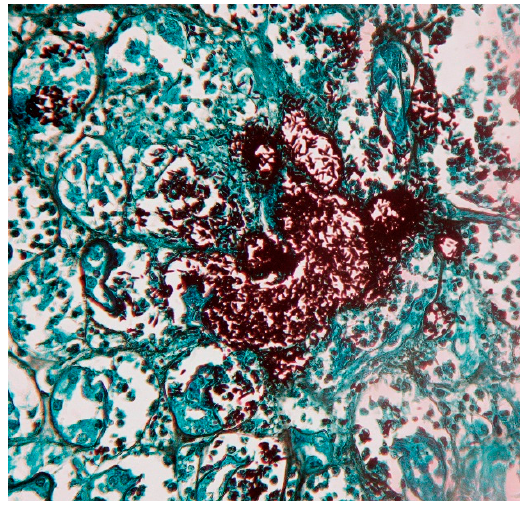
Figure 2. Biopsy of disseminated sporotrichosis. Renal biopsy with multiple clusters of lengthened yeast forms “cigar-shaped” (Grocott, 40×).